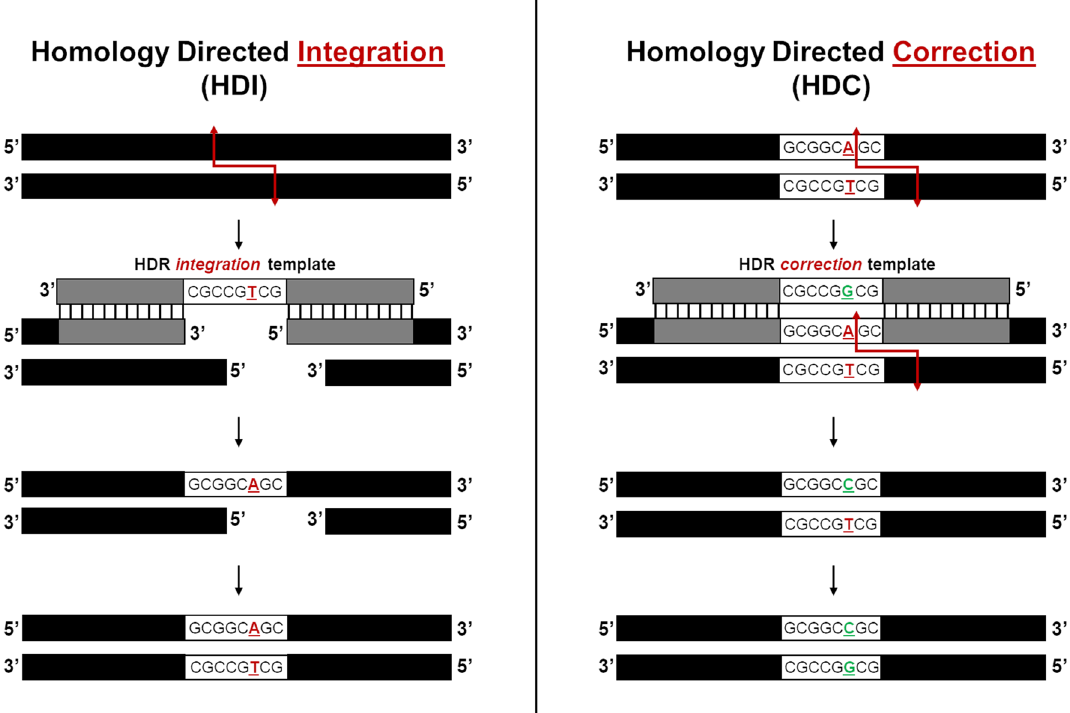
Figure 1. Homology Directed Integration (HDI) and Homology Directed Correction (HDC) reactions. Illustrations show the HDR integration template-directed HDI reaction used to generated NotI-MT plasmids (left) and HDR correction template-directed HDC reaction used for point mutation repair of NotI-MT plasmids